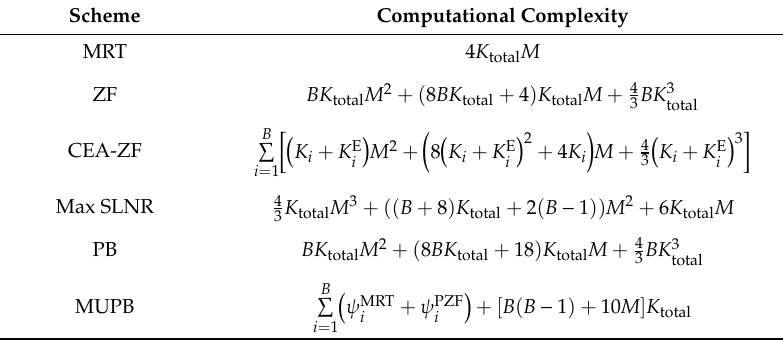
Table 1. Computational complexity for the generation of beam